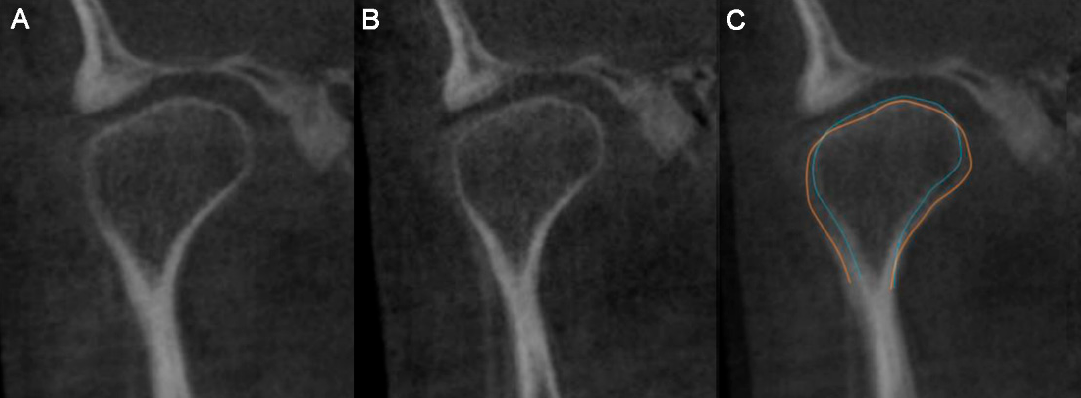
Figure 4. Overlapped radiographic images (CBCT; frontal view) of the pre-operative and post-operative natural side of the condyle. The image was selected at the largest dimension of the condyle in frontal plane. ( A ) Pre-operative radiograph on the natural side of the condyle. ( B ) Post-operative radiograph on the natural side of the condyle. ( C ) Overlapped image (pre-operative: orange line, post-operative: blue line).